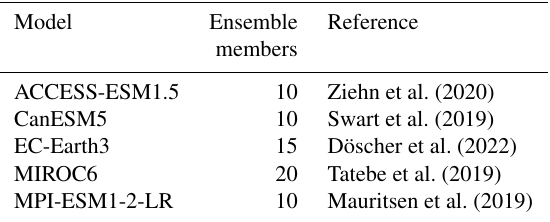
Table 1. CMIP6 models used in the study. Model Ensemble Reference members